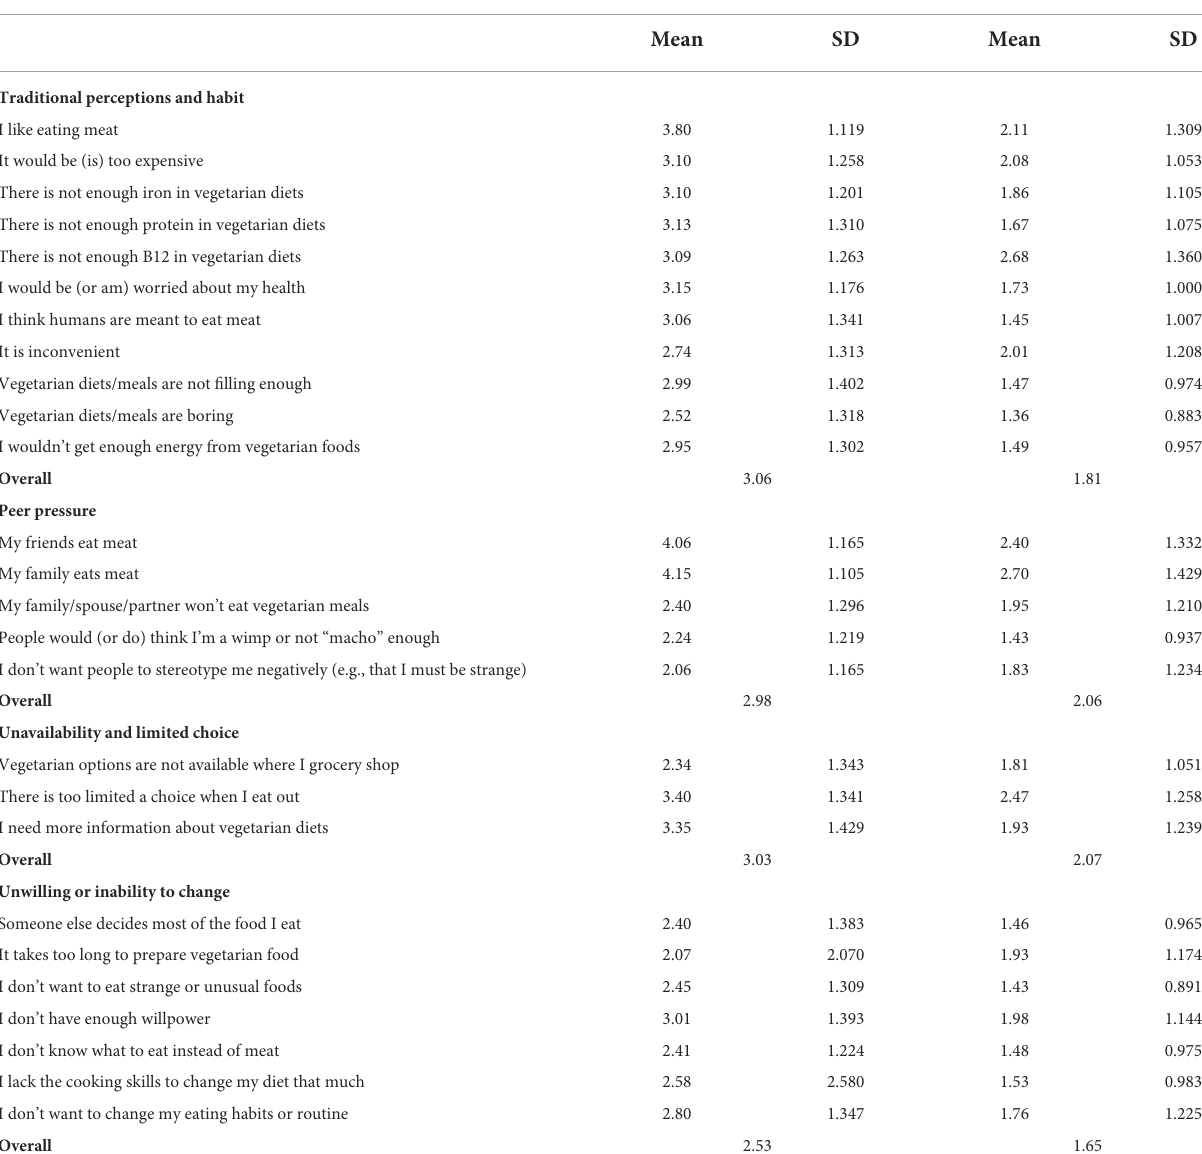
Rural Urban Mean SD Mean